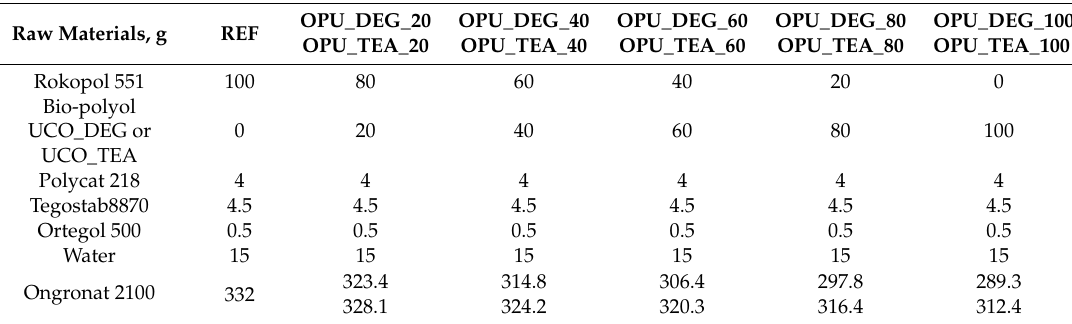
Table 2. Formulations of foams.